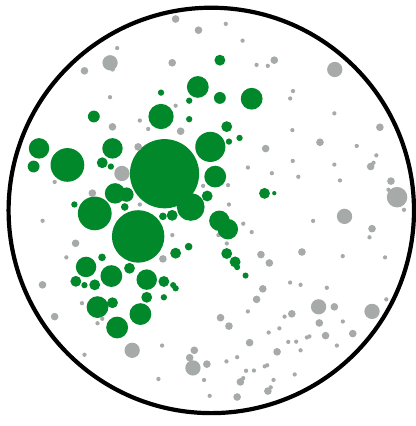
Figure 1 . Schematic picture of a jet, with circles representing radiation whose size corresponds to its energy. Wide-angle soft radiation (grey) is groomed away, resulting in the groomed jet